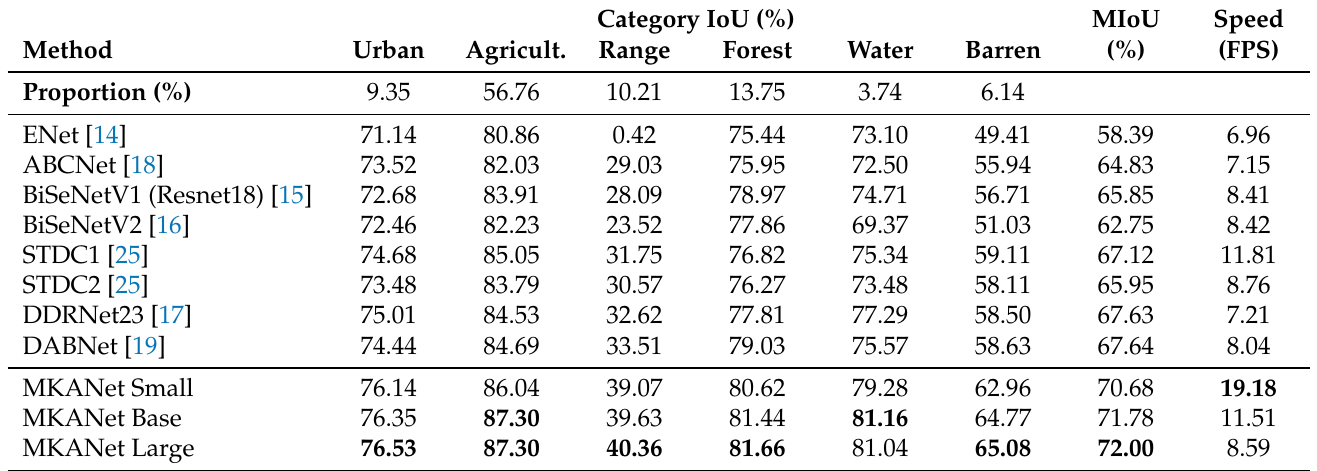
Table 4. Comparison of MKANets with other state-of-the-art lightweight networks on the DeepGlobe Land Cover dataset.